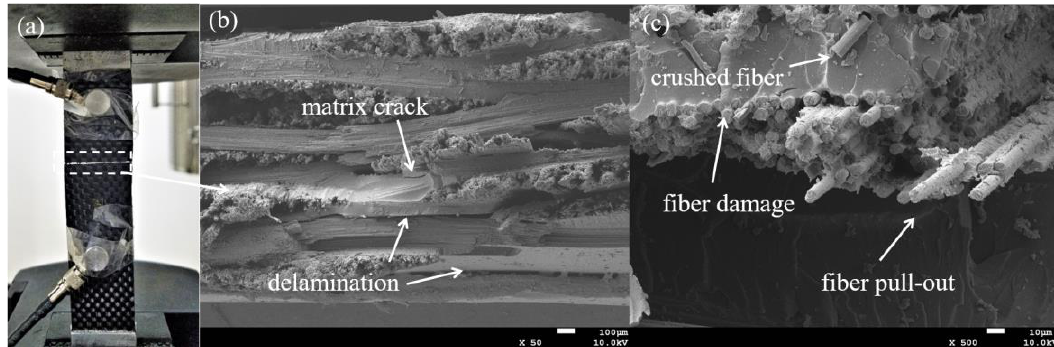
Figure 7. ( a ) The image of the whole fractured sample. ( b , c ) SEM micro-photographs of the fractured composite: delamination and matrix crack; fiber breakage and fiber pull out. composite: delamination and matrix crack; fiber breakage and fiber pull